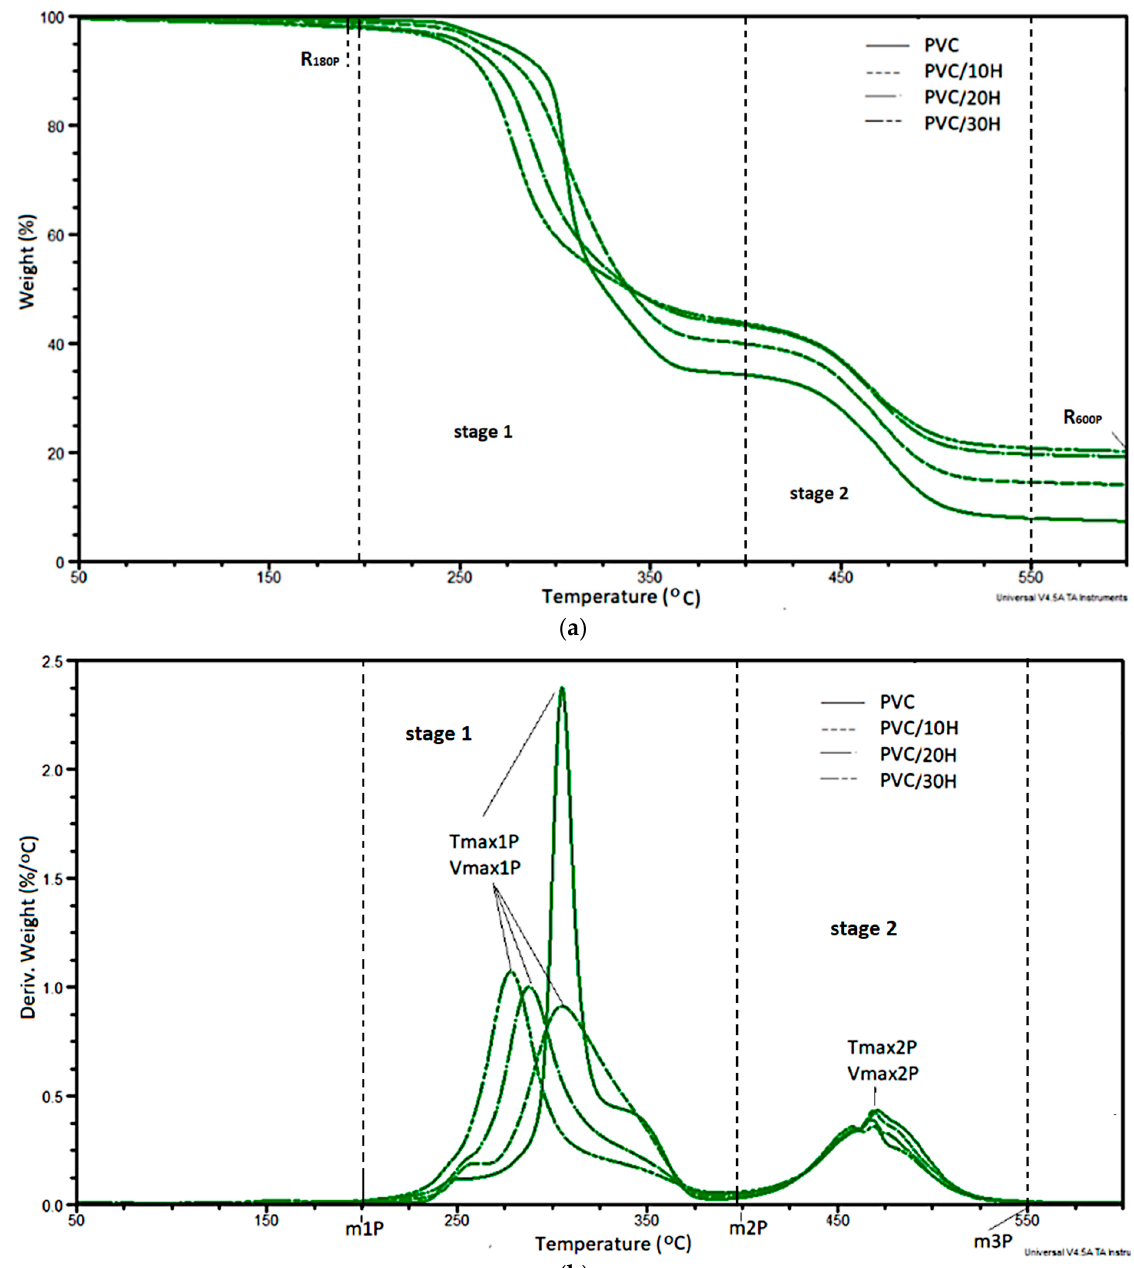
Figure 5. Thermograms of unfilled PVC and PVC composites: ( a ) TG and ( b ) DTG. On the basis of the TG curves, the temperature of 2% mass loss (T 2%P ), the mass loss at 180 °C (R 180P ) and the degradation residue at 600 °C (R 600P ) were determined. In turn, the DTG curves were used to determine the temperature of the maximum degradation rate at each stage (T max1P , T max2P ), the maximum degradation rate at temperatures (V max1P , V max2P ) and the mass change at each stage: Δ m 1P = m 1P –m 2P , Δ m 2P = m 2P –m 3P , respectively. The re- sults of the analysis of the changes in these parameters are summarized in Table 4. Table 4. The results of thermostability analysis by Congo and analysis of TG and DTG curves of poly(vinyl chloride) and PVC composites. Parameter